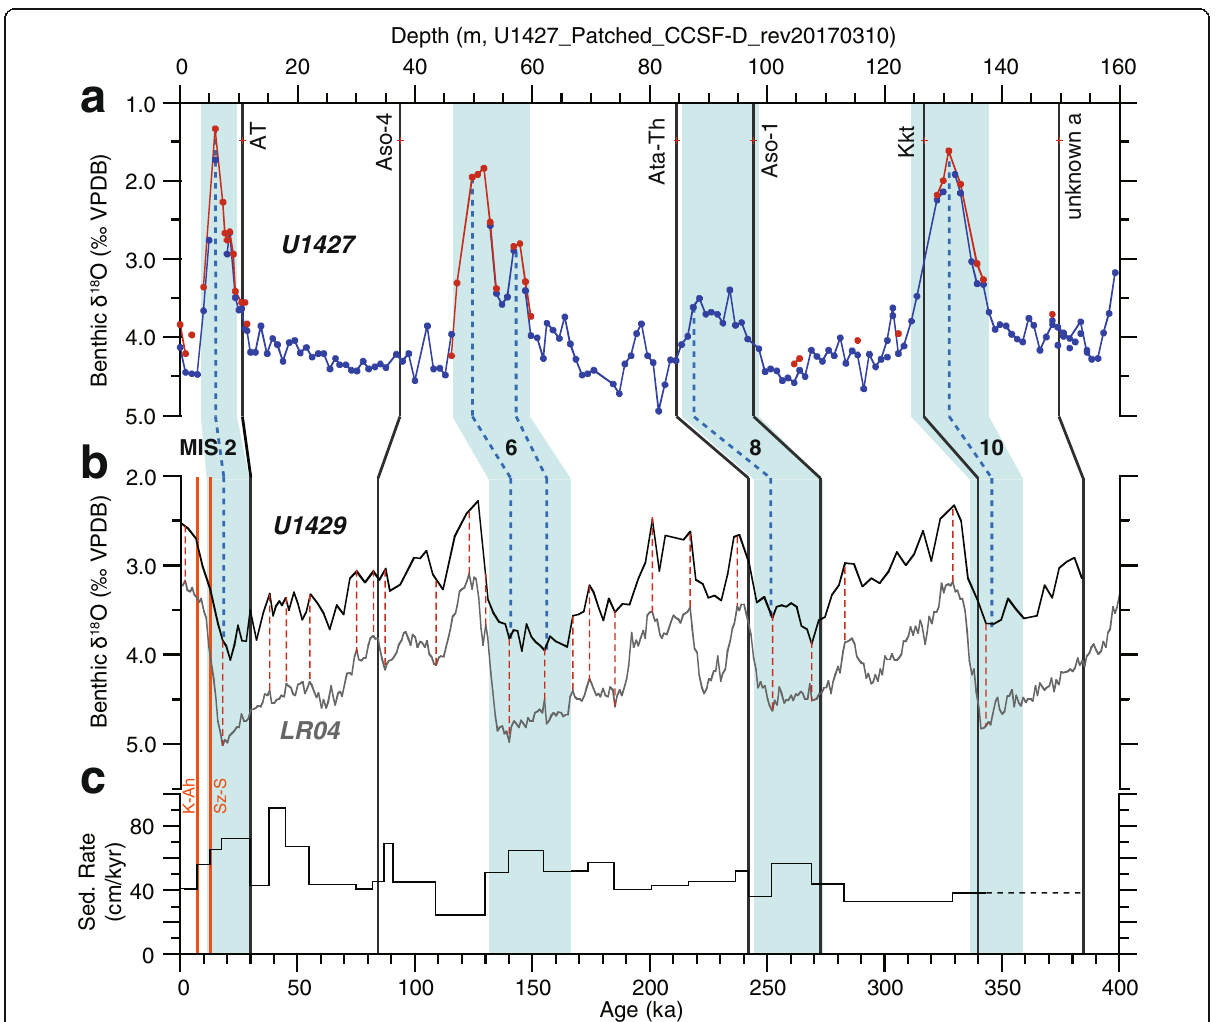
Fig. 6 Comparison of benthic foraminiferal δ 18 O records at Sites U1427 ( a ) and U1429 ( b ). Red dotted lines in b indicate age control points correlating U1429 δ 18 O measurements and the LR04 stack. c Sedimentation rate at Site U1429. The positions of two tephra layers, K-Ah and Sz-S, used to constrain the Site U1429 age model are shown by vertical lines (see text for